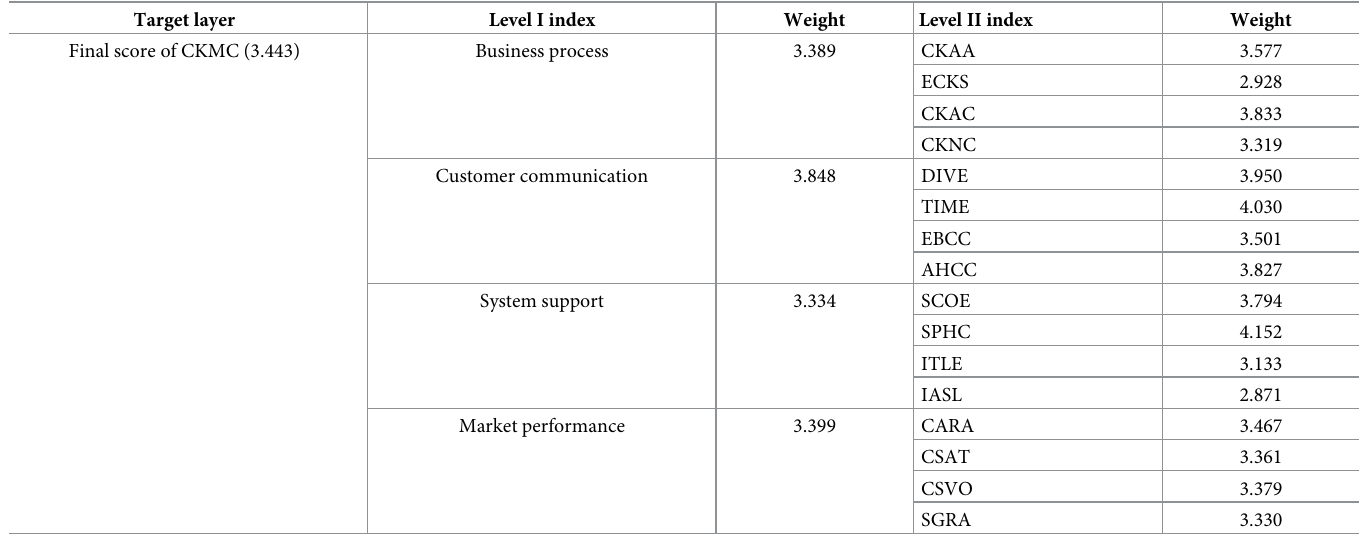
Table 6. Final score of